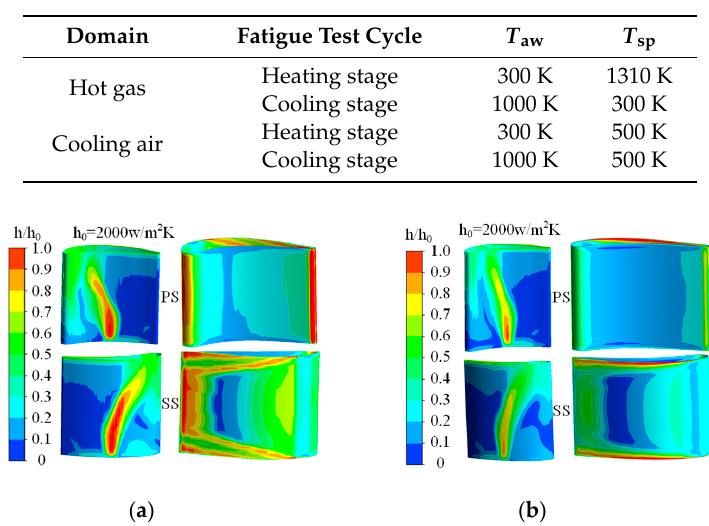
Figure 10. Convection heat transfer coefficient of the heating and cooling stages. ( a ) Heating stage; ( b ) Cooling stage.